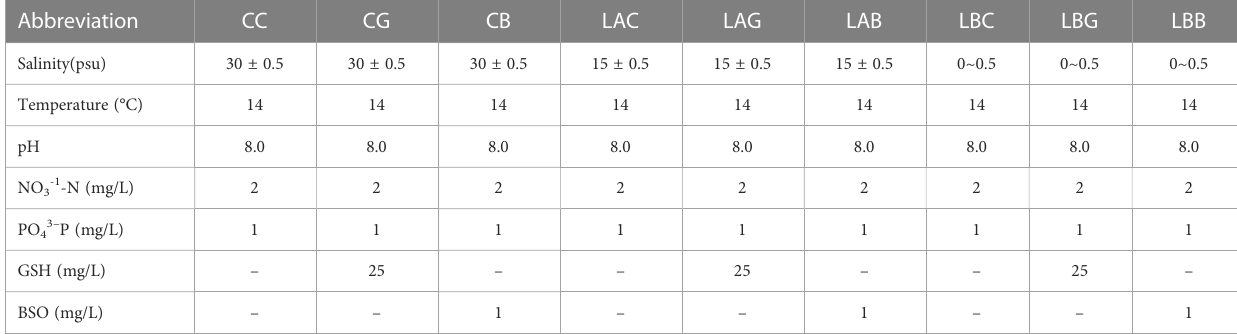
TABLE 1 The main components in and the abbreviation of each